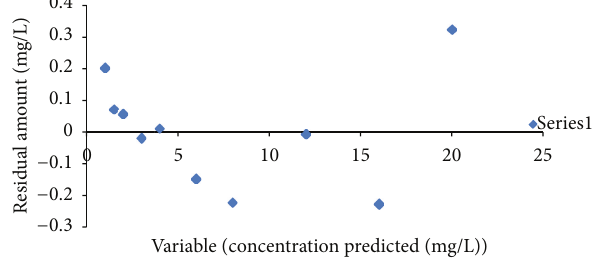
Figure 3: Residual amount v/s variable